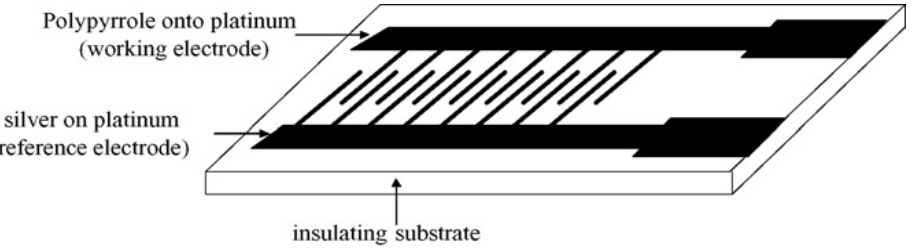
Figure 3. Schematic drawing of interdigitated microarray electrodes. Reprinted from [57] © 2007 with permission from Elsevier.